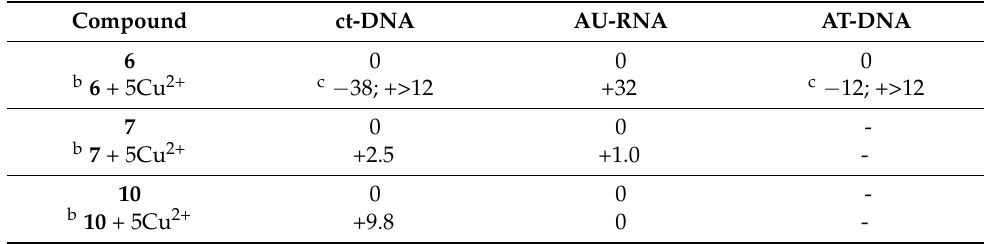
0 c − 38; +>12 0 +2.5 0 +9.8